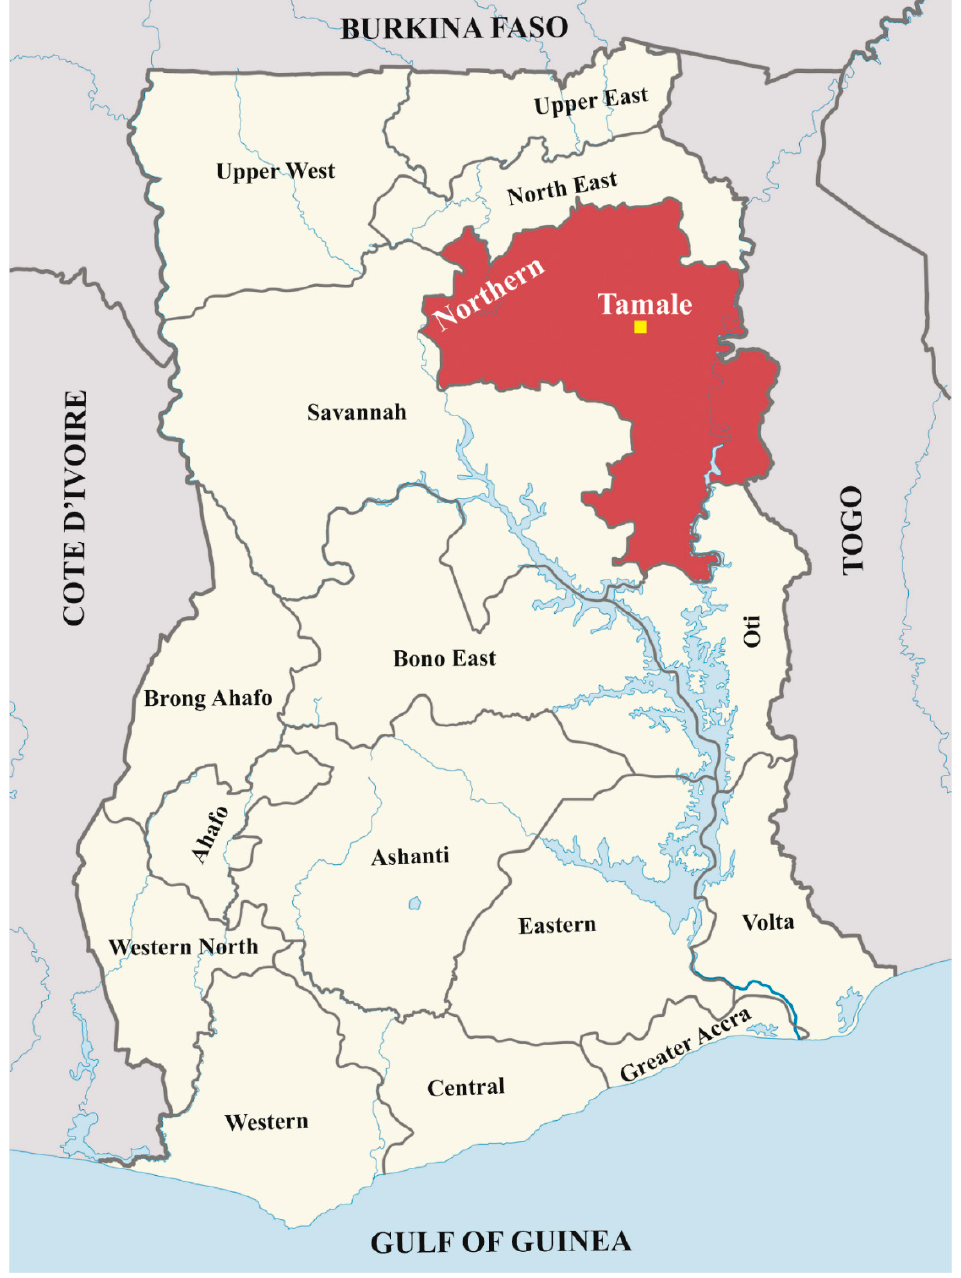
Figure 1. Map of Ghana showing the study area, Tamale Metropolis. (Adapted and modified from https://commons.wikimedia.org/w/index.php?curid=75391034).